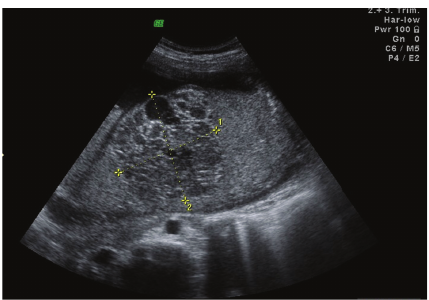
Figure 1: The gray-scale ultrasonography of Case 1 showing 7 × 7 × 6 cmhypoechoic,well-circumscribedintraplacentalmasswithsome anechoic areas.